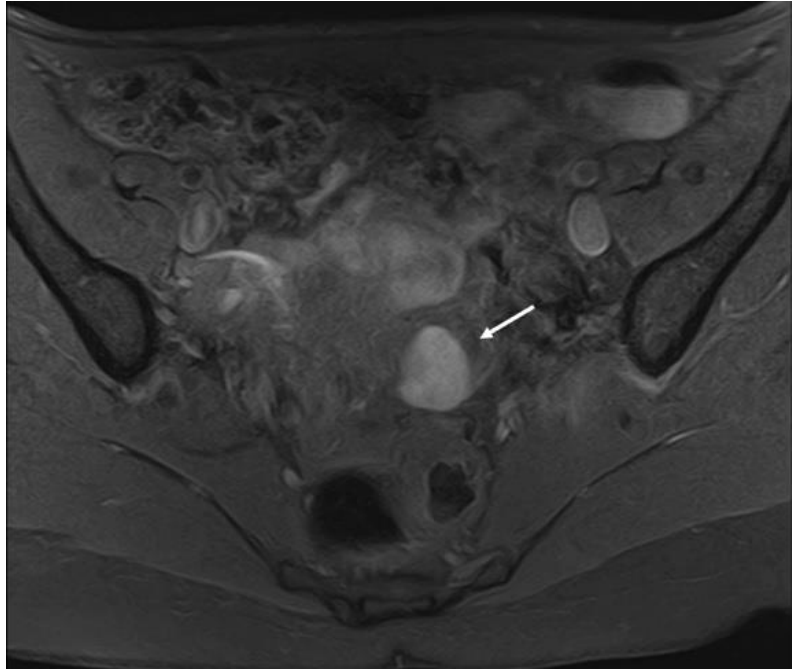
Figure 6. MRI imaging method: an endometrioma indicated by an arrow in the axial